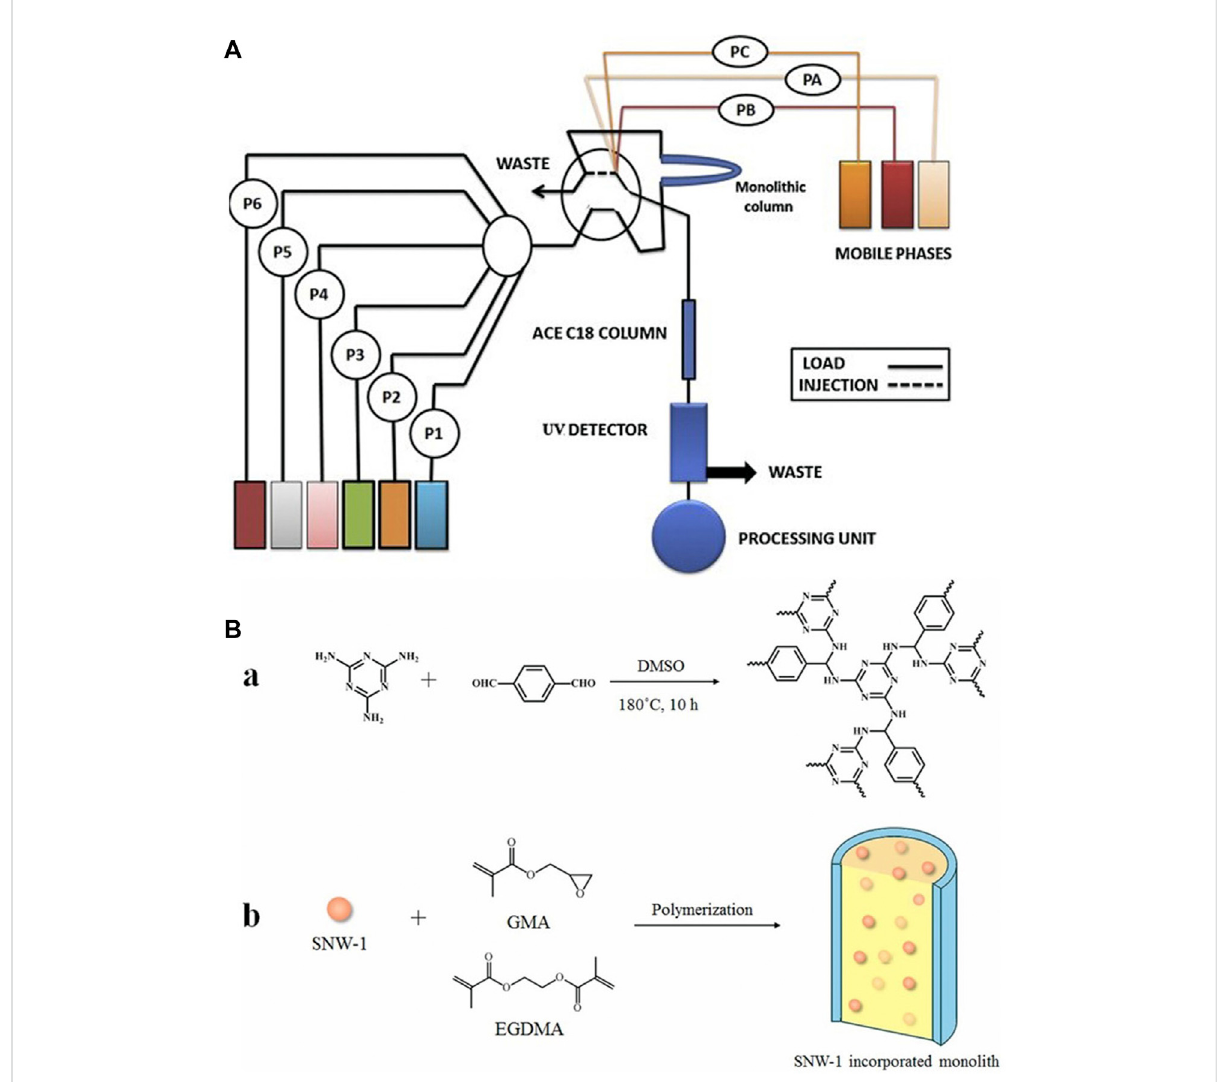
FIGURE 7 (A) : Schematic representation for operation of the on-line assay of the tramadol by monolithic column coupled with HPLC. Reprinted with permission from Ref. (Javanbakht et al., 2012). Copyright 2012 Elsevier (B) : Schematic of (A) synthesis of SNW-1 and (B) preparation of SNW-1- monolithic column. Reprinted with permission from Ref. (Wang R. et al., 2021). Copyright 2021